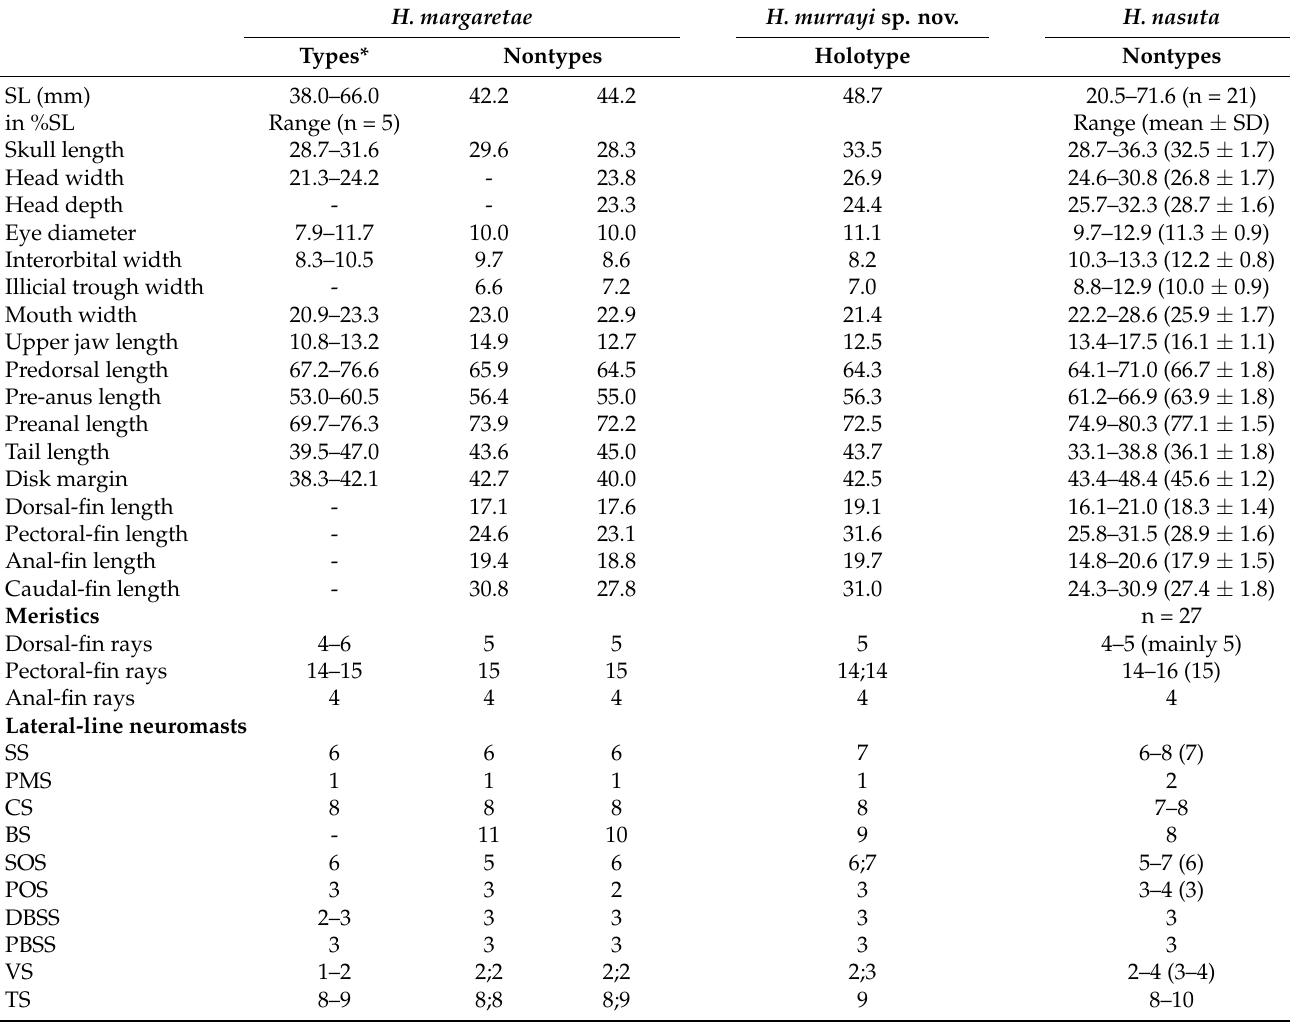
Table 7. Morphometric and meristic data of H. margaretae , H. murrayi sp. nov. and H. nasuta . * Data taken from Ho and Shao